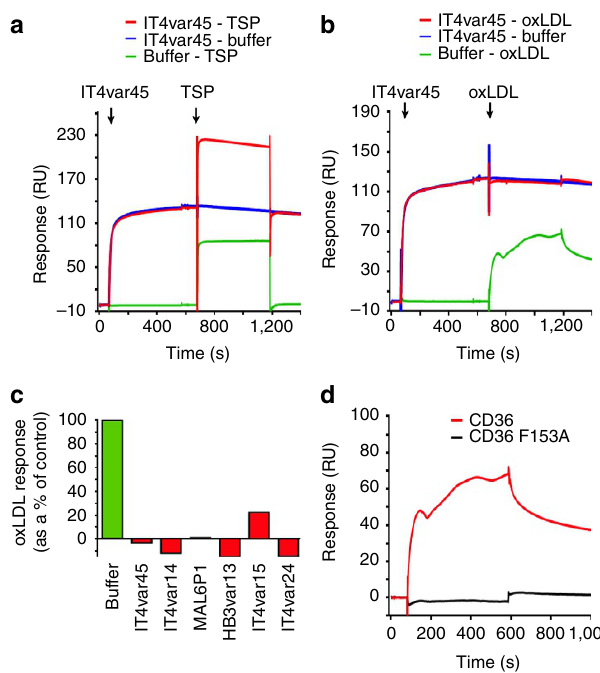
Figure 6 | PfEMP1 proteins prevent oxidized LDL from binding to CD36. ( a ) Surface plasmon resonance analysis showing that the preincubation of CD36 with IT4var45 CIDR a 2.9 does not affect the binding of thrombospondin (TSP) to CD36. ( b ) Surface plasmon resonance analysis showing that the preincubation of CD36 with IT4var45 CIDR a 2.9 prevents the binding of oxidized LDL particles (oxLDL) to CD36. ( c ) SPR data showing the inhibition of oxLDL binding to CD36 by a panel of CIDR a 2-6 domains. ( d ) Demonstration by surface plasmon resonance that the F153A mutation blocks the binding of oxLDL to